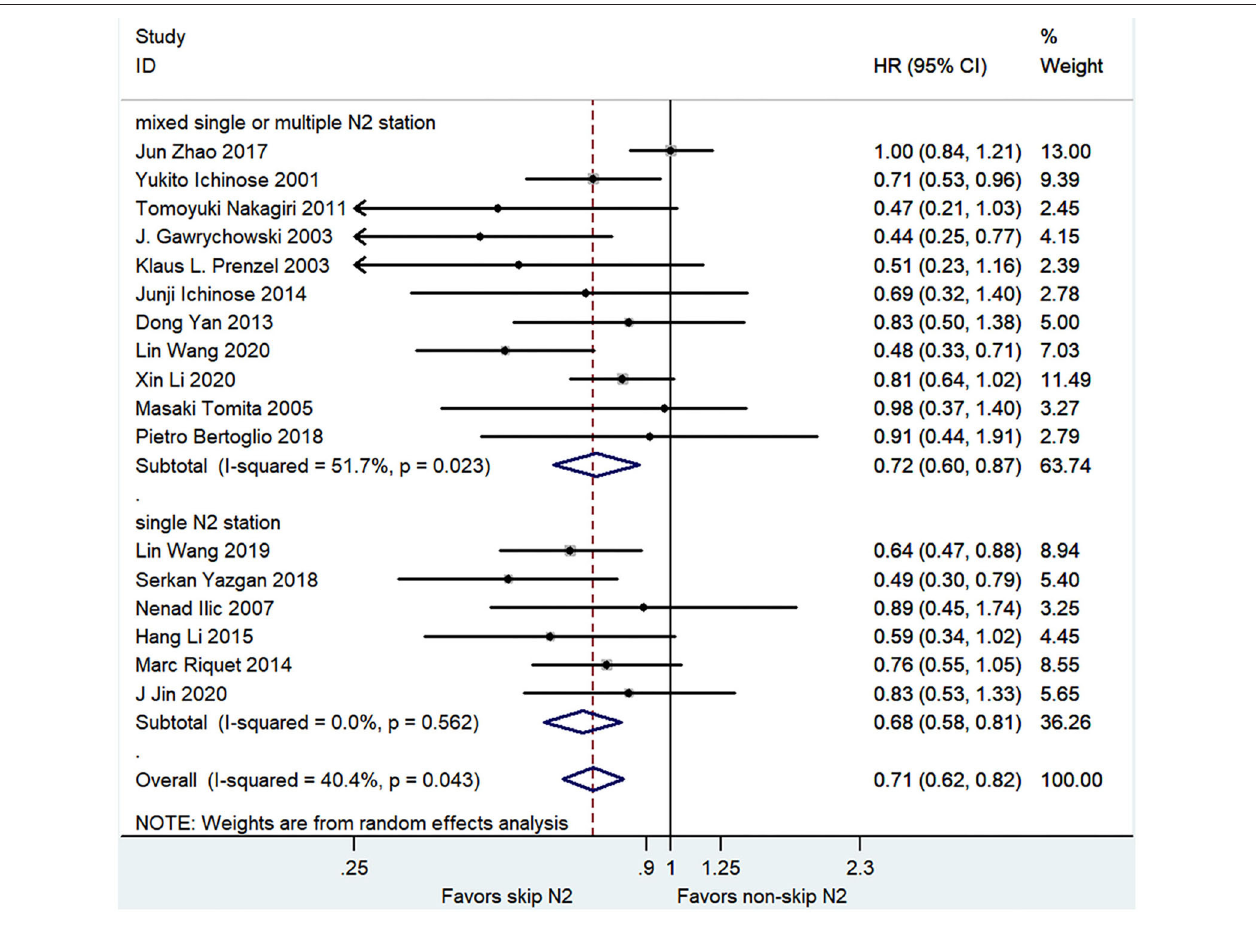
FIGURE 2 | Pooled hazard ratio (HR) for overall survival (OS).